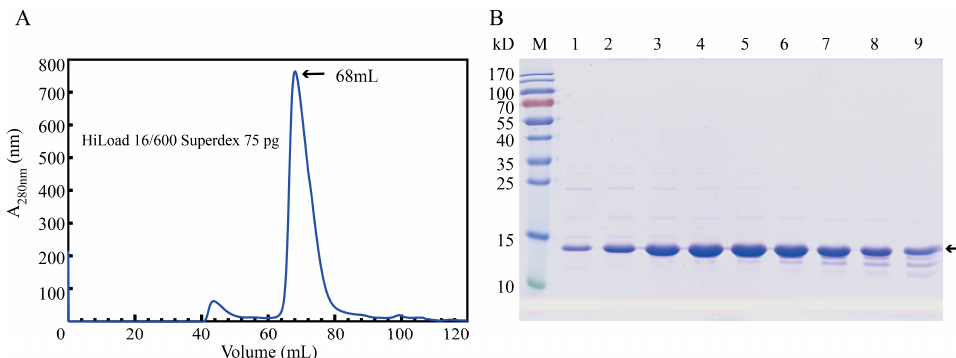
Figure 2. Purification of the recombinant BmGlv2. ( A ) Purification of the recombinant BmGlv2 by gel filtration. ( B ) SDS-PAGE analysis of the purified BmGlv2 protein. M: marker, 1 to 9: the fractions of elution peak.